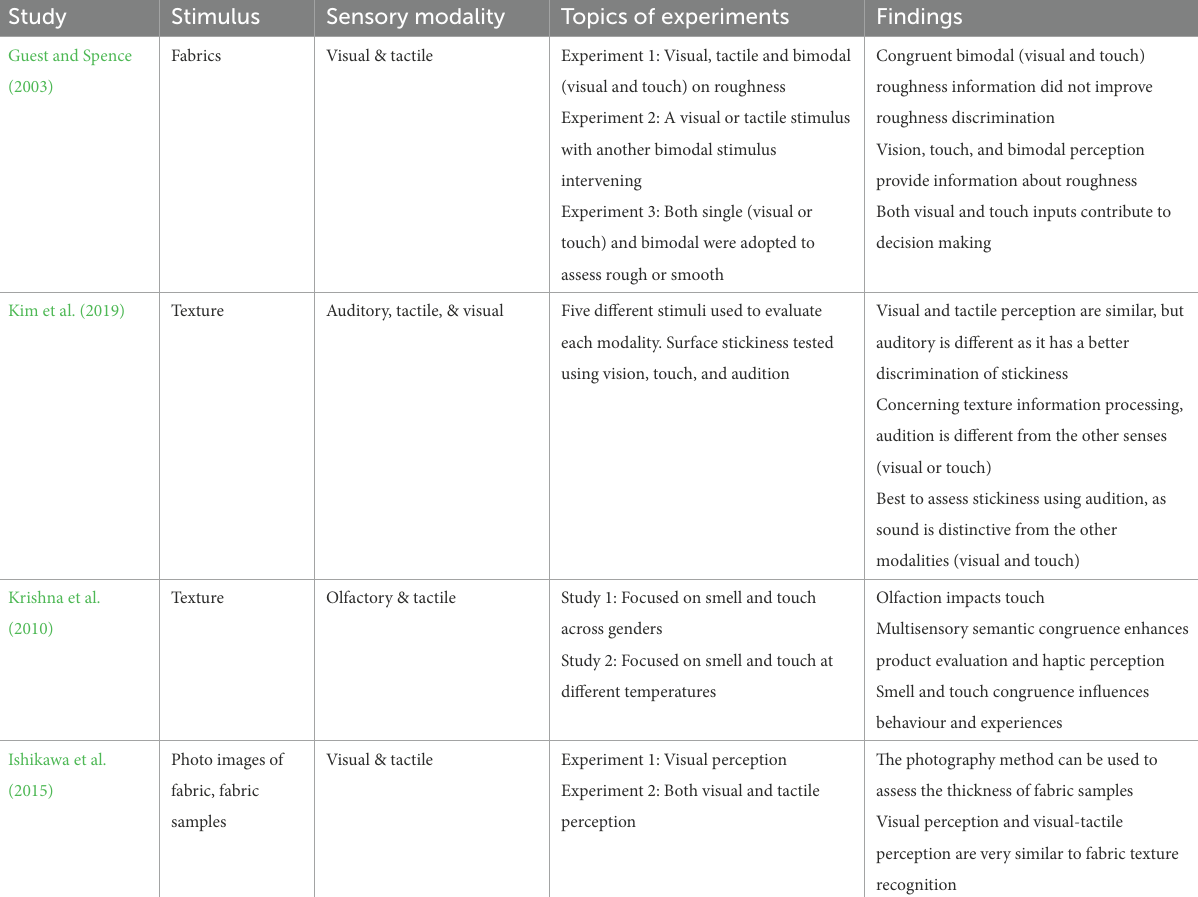
TABLE 2 Summary of studies that have investigated the effect of multisensory perception on texture.